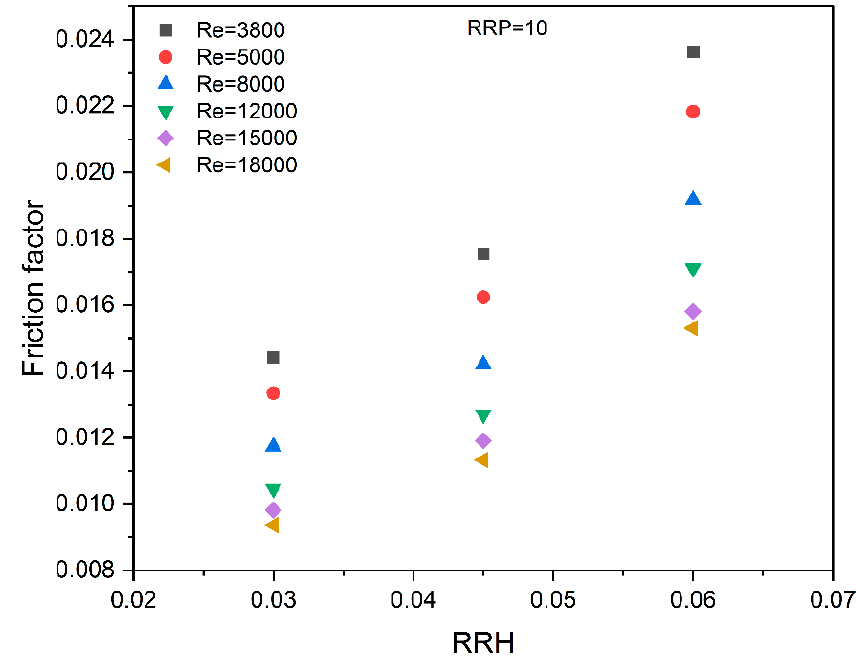
Figure 17. f r versus RRH .